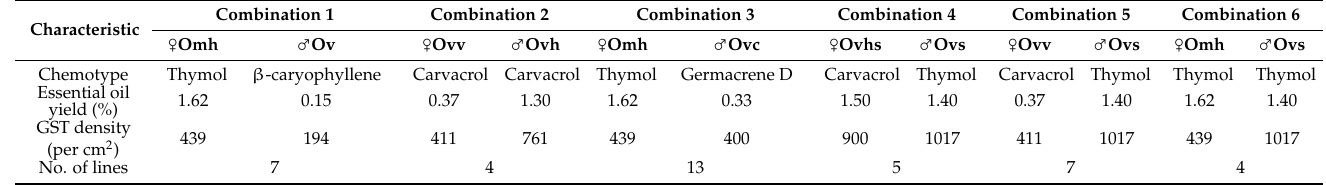
Table 2. Characteristics of six oregano hybrid